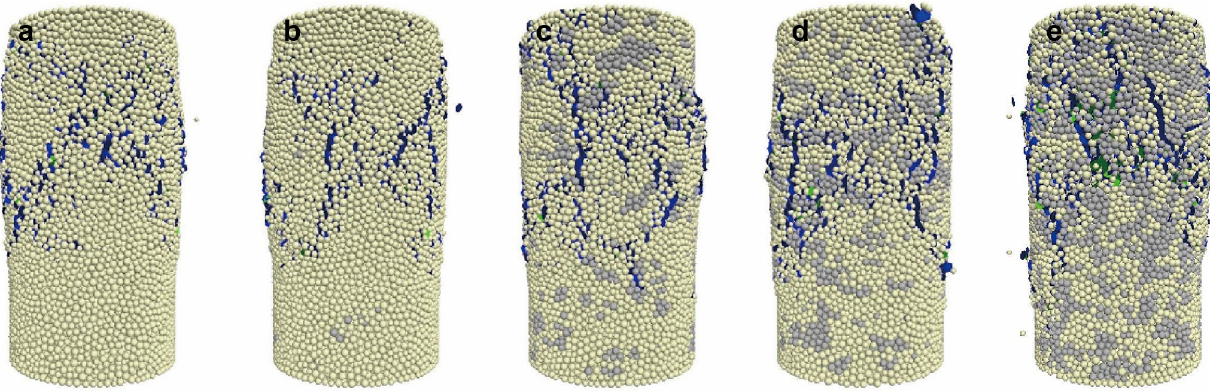
Fig. 13 Failure patterns of the PFC3D models with various rock ratios (images a – e represent rock ratios of 0%, 10%, 20%, 30% and 50%, respectively)